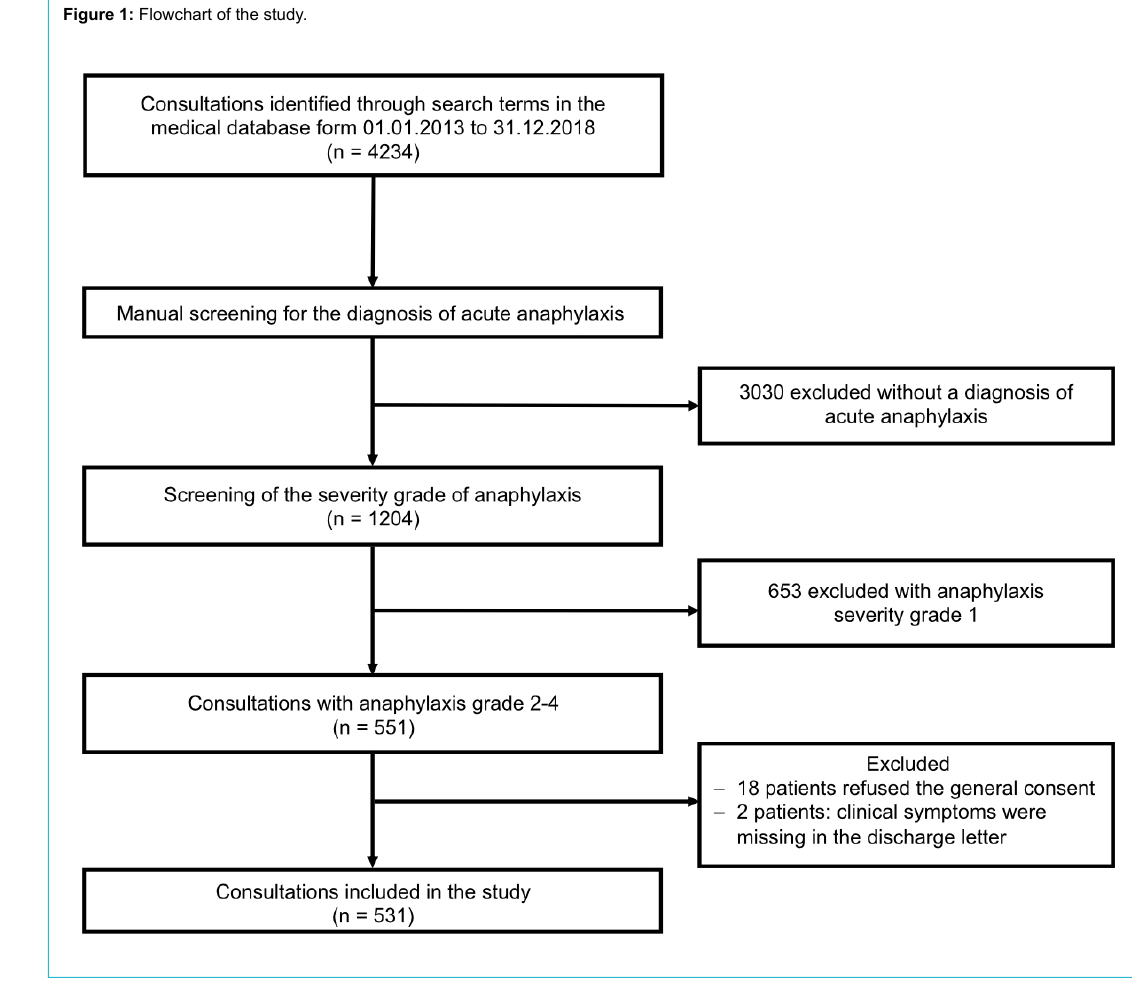
Figure 1: Flowchart of the